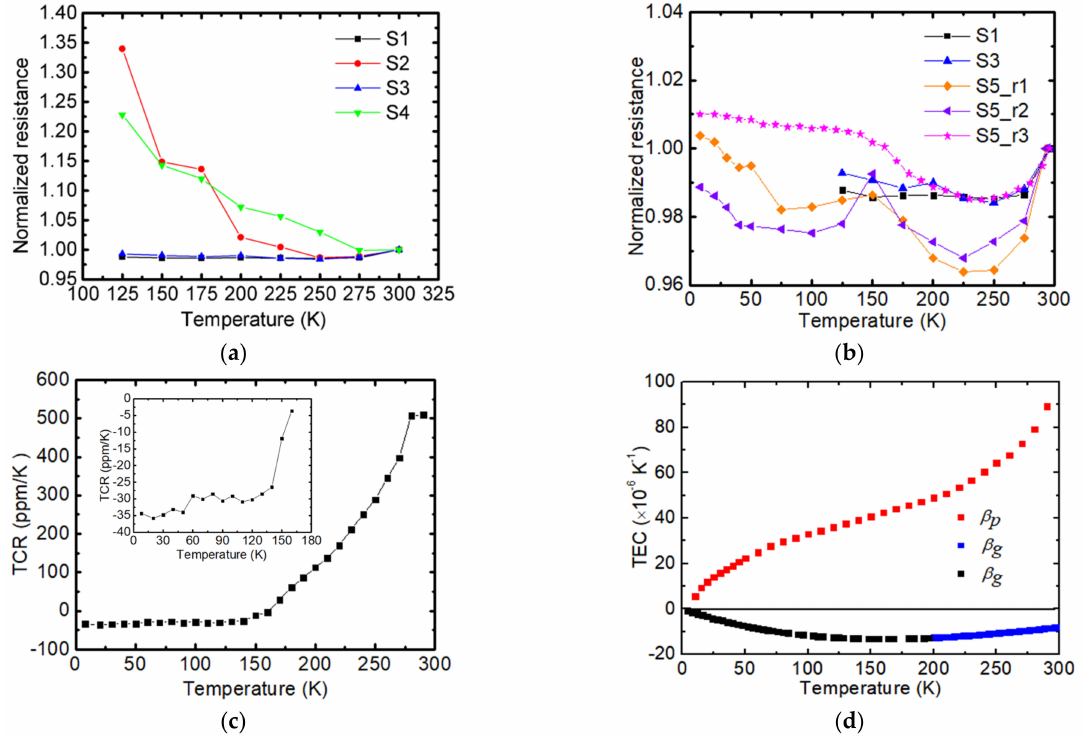
Figure 4. ( a ) Normalized resistance of S1, S2, S3, and S4. ( b ) Normalized resistance of S1, S3, S5_r1, S5_r2. and S5_r3. ( c ) Temperature coefficient of resistance of S5. The TCR was obtained based on the data of S5_r3. ( d ) Thermal expansion coefficient of PMMA (Reprinted/adapted with permission from Ref. [39]. Copyright 2013, Elsevier) and suspended graphene (Reprinted/adapted with permission from Ref. [40]. Copyright 2011, American Chemical Society). The data in blue square are obtained through experiment while the data shown in black square are estimated